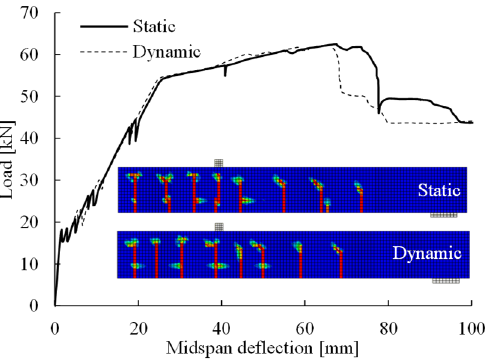
Figure 18. Comparison of the solution strategies between the static general analysis and the dynamic implicit analysis for the load–deflection relations and crack patterns.